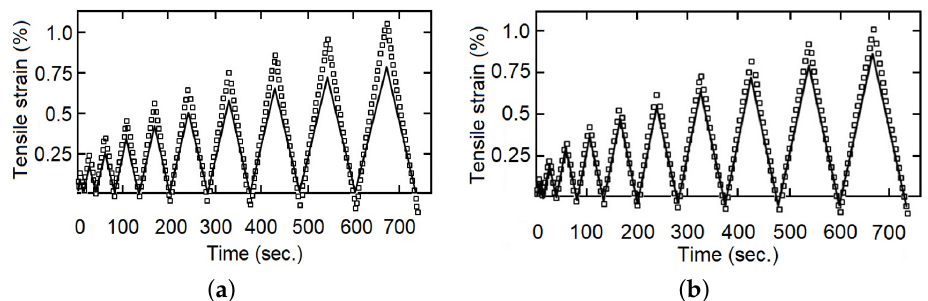
Figure 8. Tensile strain for loading–unloading test, one specimen with 9 wt%, experimental data in dots and model response in continuous line, ( a ) integer index model, ( b ) fractional index model.